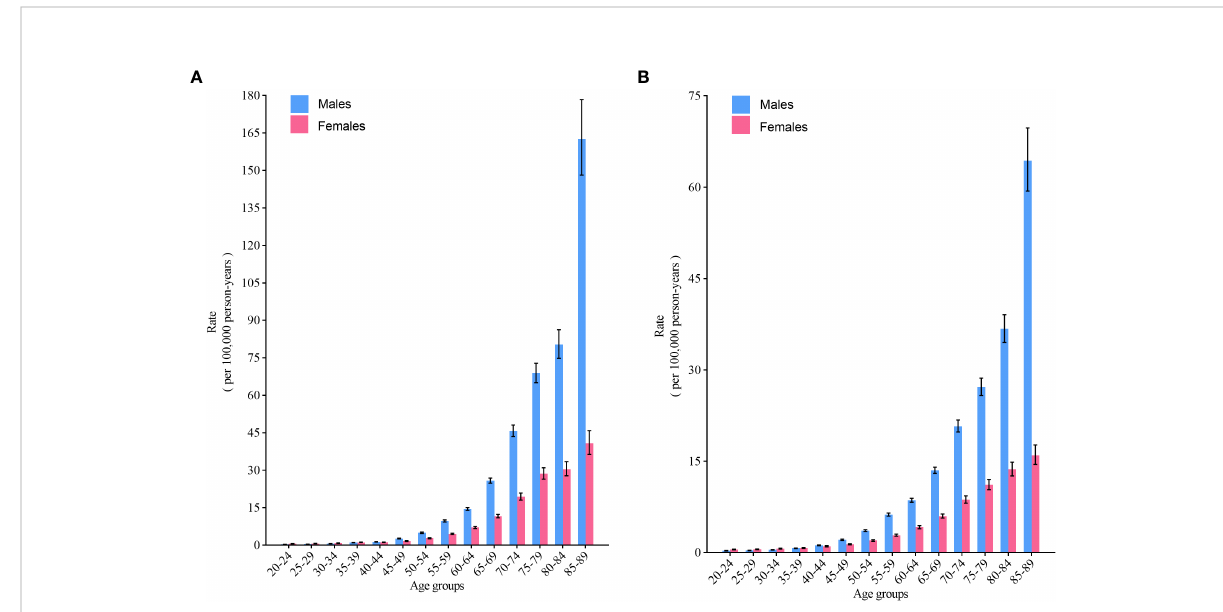
FIGURE 4 Fitted longitudinal age-speci fi c rates of non-Hodgkin lymphoma and the corresponding 95% CI. (A) incidence; (B)